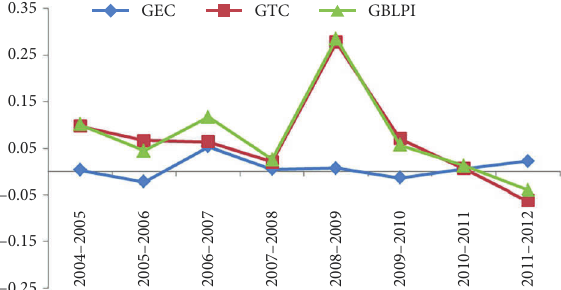
Figure 2. Trends in GBLPI, GEC and GTC of the